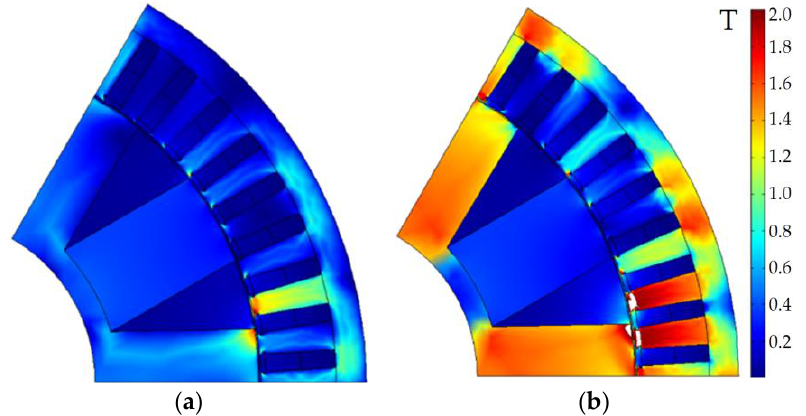
Figure 13. Pole-sector geometry of the generator for the optimized design. White color shows areas with flux density more than 2 T: ( a ) Maximum speed; ( b ) Maximum torque. Table 3. Generator characteristics before and after optimization.